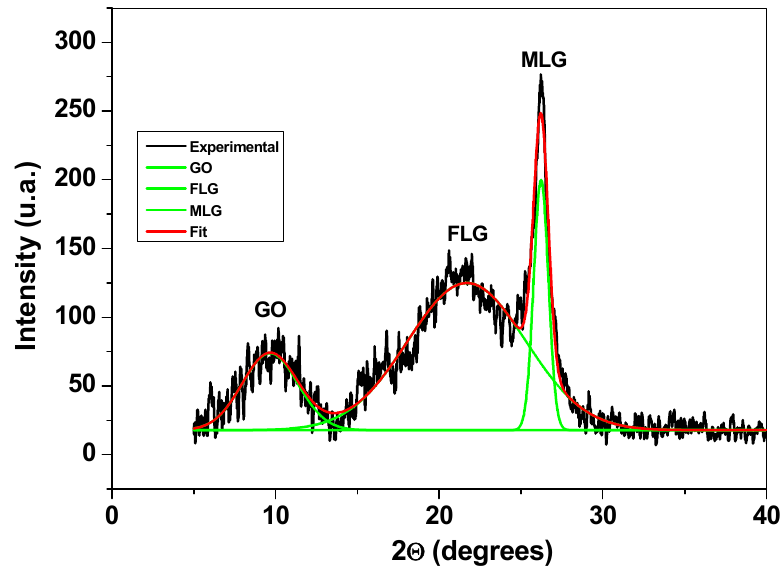
Figure 3. The XRD pattern of the graphene sample and the corresponding deconvoluted peaks. For each peak, the D value was calculated from the full width at half maximum (FWHM) using the Debye–Scherrer equation (Equation (1)): 0.9 ∗ λ D = (1) 𝛽 ∗ cos 𝜃 where λ is the X-ray wavelength, β is FWHM expressed in radians, and θ is half the diffraction angle of the peak (in degrees), corresponding to interlayer distance, d . The d value was found with the Bragg equation ( d = λ /2 sin θ ), while the average number of layers, n , was calculated from the relation n = D/d [30].